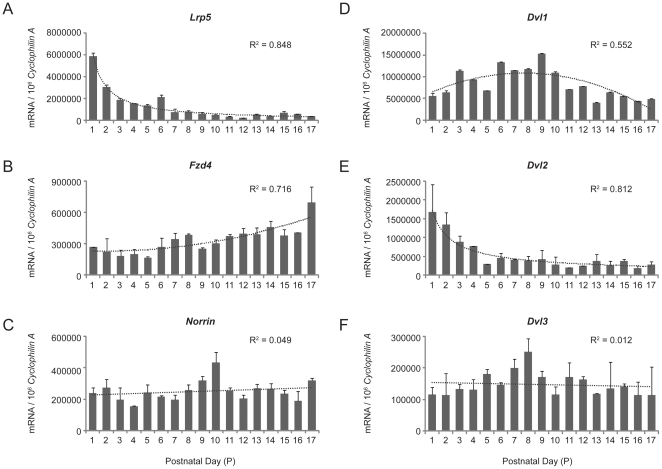
Expression levels of Lrp5, Norrin, Frizzled4 and Dvl mRNA during retinal development in wild type mice.Quantification of mRNA (A) Lrp5, (B) Norrin, (C) Frizzled4, (D) Dvl1, (E) Dvl2, and (F) Dlv3 was performed with RT-qPCR during normal retinal development from P1-P17. Expression levels were normalized against house keeping gene Cyclophilin A. Trend lines were fitted with polynomial, linear or power regression.